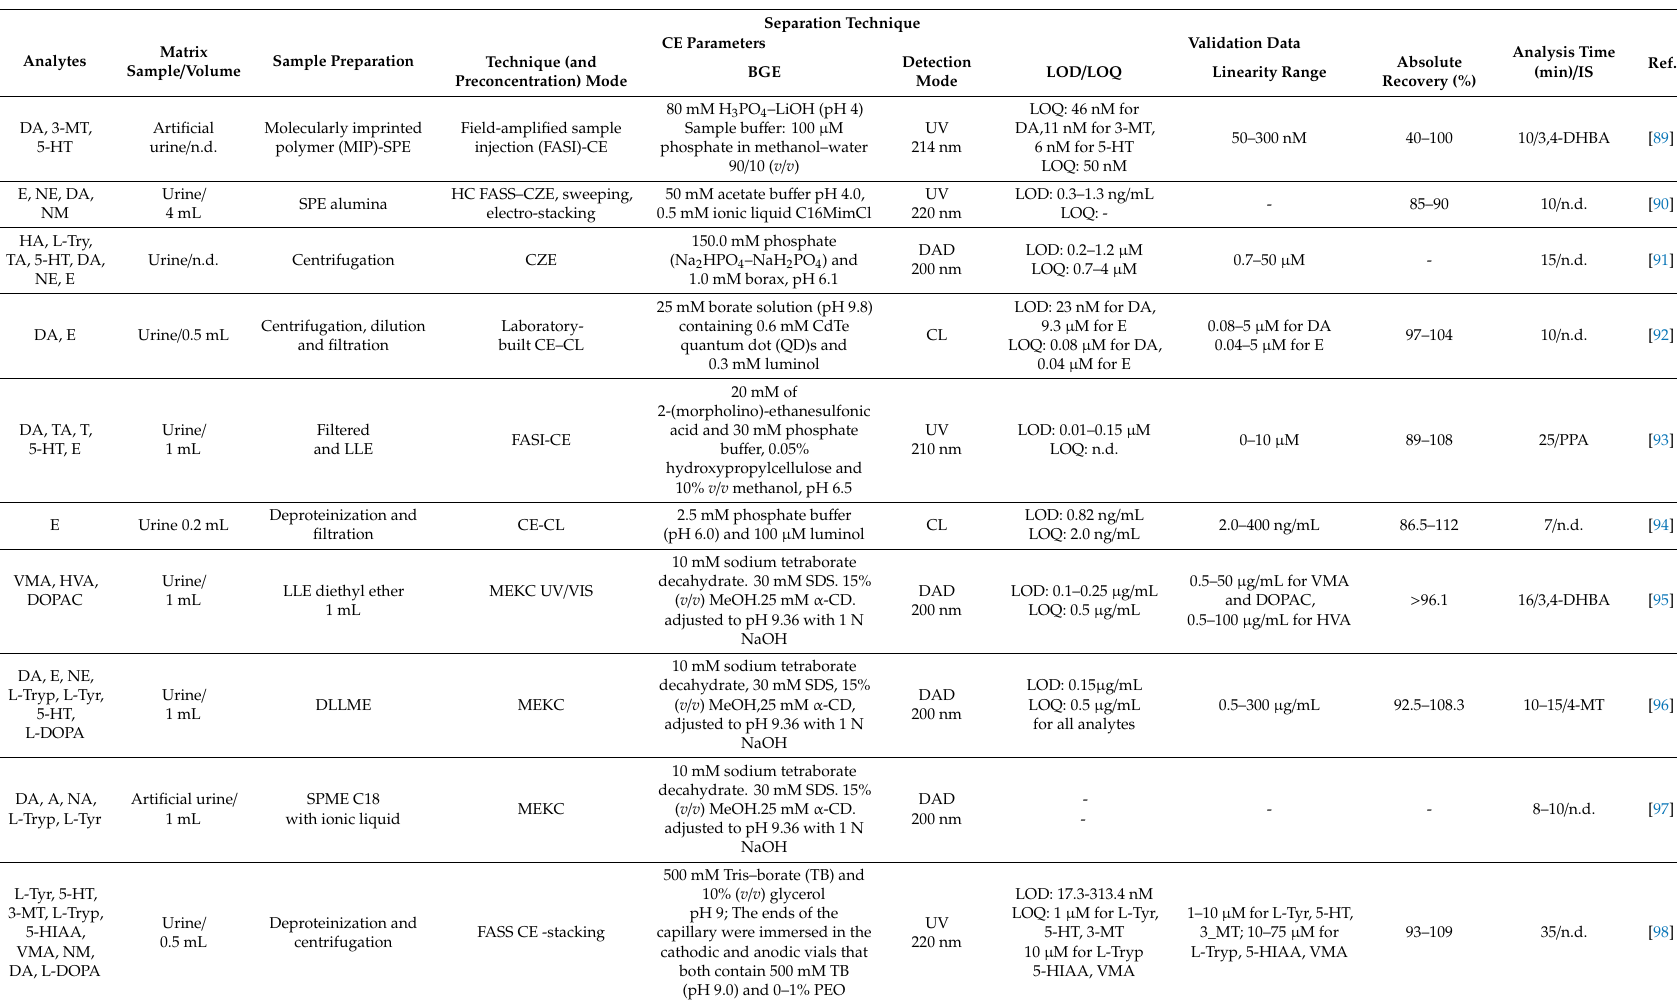
Table 4. Information on parameter methodologies based on the electromigration techniques developed for BA determinations in human samples since